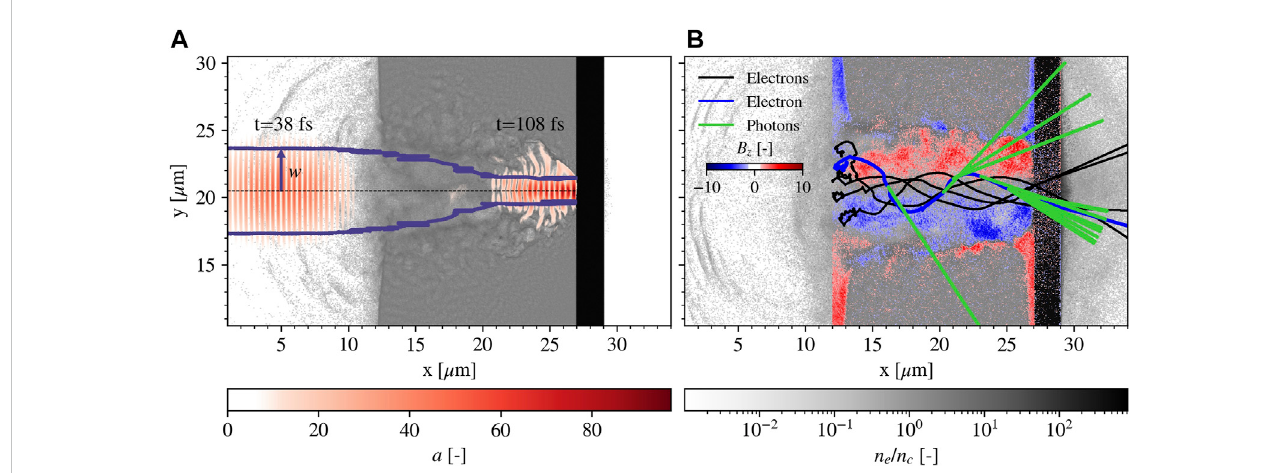
FIGURE 1 Evolution of the laser and trajectories of some electrons in simulation A. Plot (A) shows in blue lines the laser waist limits, calculated as the points where the fi eldamplitudefallsto1/eofitsmaximum,andtwosnapshotsof a = e | E |/( m e ω 0 c )at38fsand108fs.Theblackdashedlineindicatesthecenteroftheboxin y .Plot (B) showssometrajectoriesofelectrons andphotonsandthe fi eld B z normalizedtothecodeunitsat204fs. Therepresented electrons (black andblue lines) are characterized by a fi nal value of kinetic energy above 60 MeV. The photons (green lines) are emitted by the electron represented in blue. In the background of both plots, the electron density normalized to n c at 108 fs in (A) and 204 fs in (B)